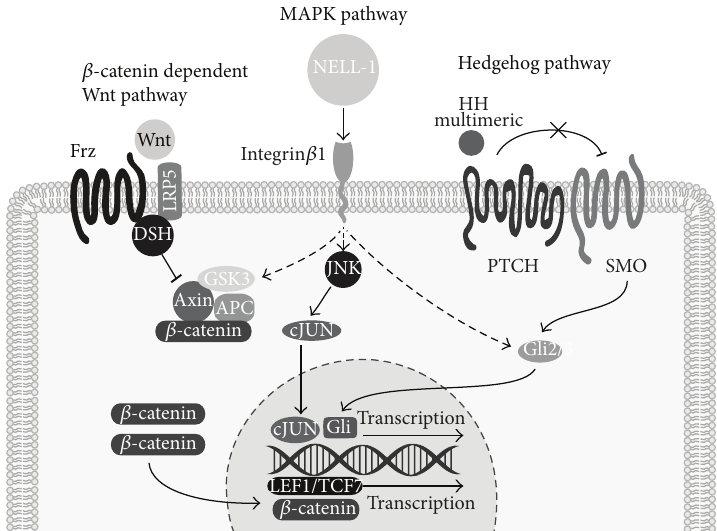
Figure 5: Schematic of NELL-1 signaling pathway. NELL-1 is a secreted osteoinductive protein that binds to the cell surface receptor Integrin 𝛽 1. Binding to Integrin 𝛼 3 has also been reported. Multiple intracellular signaling pathways have been shown to increase after NELL-1 stimulation, including MAPK, Hedgehog, and 𝛽 -catenin dependent Wnt signaling. Although the relative importance of these pathways is still undefined, NELL-1 treatment results in increased Runx2 transcription, Runx2 phosphorylation, and induction of osteogenic